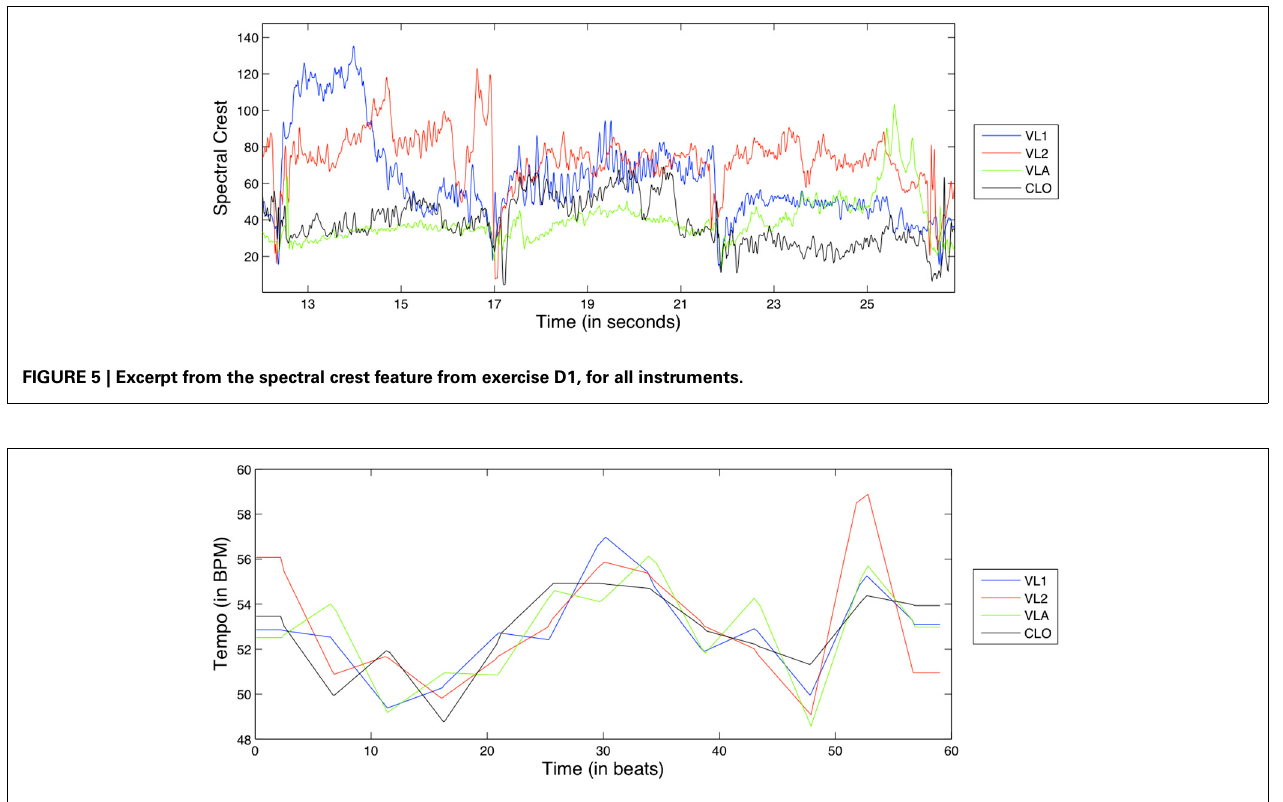
FIGURE 6 | Tempo curve feature for exercise D1, for all